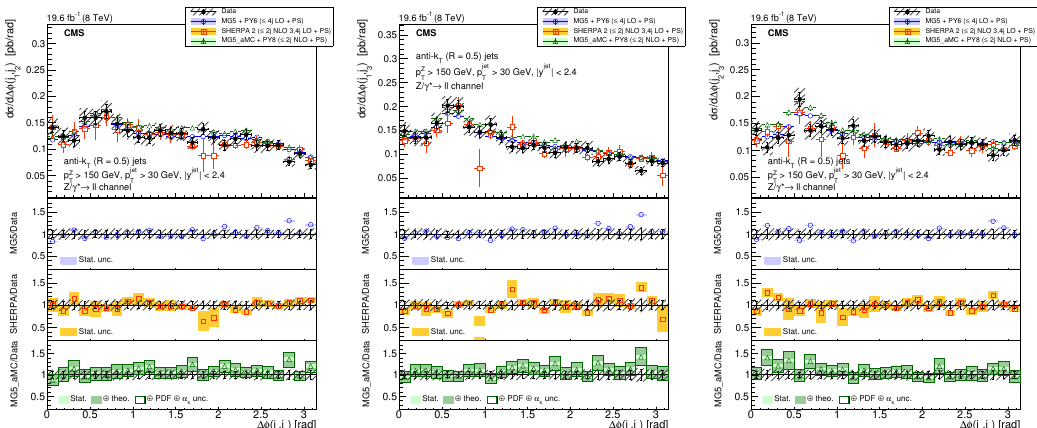
Figure 26 . The di(cid:11)erential cross section for Z ( ! ‘‘ ) + jets production for N jets (cid:21) 3 and p T (Z) > 150 GeV as a function of the azimuthal angle between (left) the (cid:12)rst- and second-, (mid- dle) the (cid:12)rst- and third-, and (right) the second- and third-leading jets. The lower panels show the ratios of the theoretical predictions to the measurements. Error bars around the experimen- tal points show the statistical uncertainty, while the cross-hatched bands indicate the statistical and systematic uncertainties added in quadrature. The boxes around the mg5 a mc + pythia 8 to measurement ratio represent the uncertainty on the prediction, including statistical, theoretical (from scale variations), and PDF uncertainties. The dark green area represents the statistical and theoretical uncertainties only, while the light green area represents the statistical uncertainty alone.